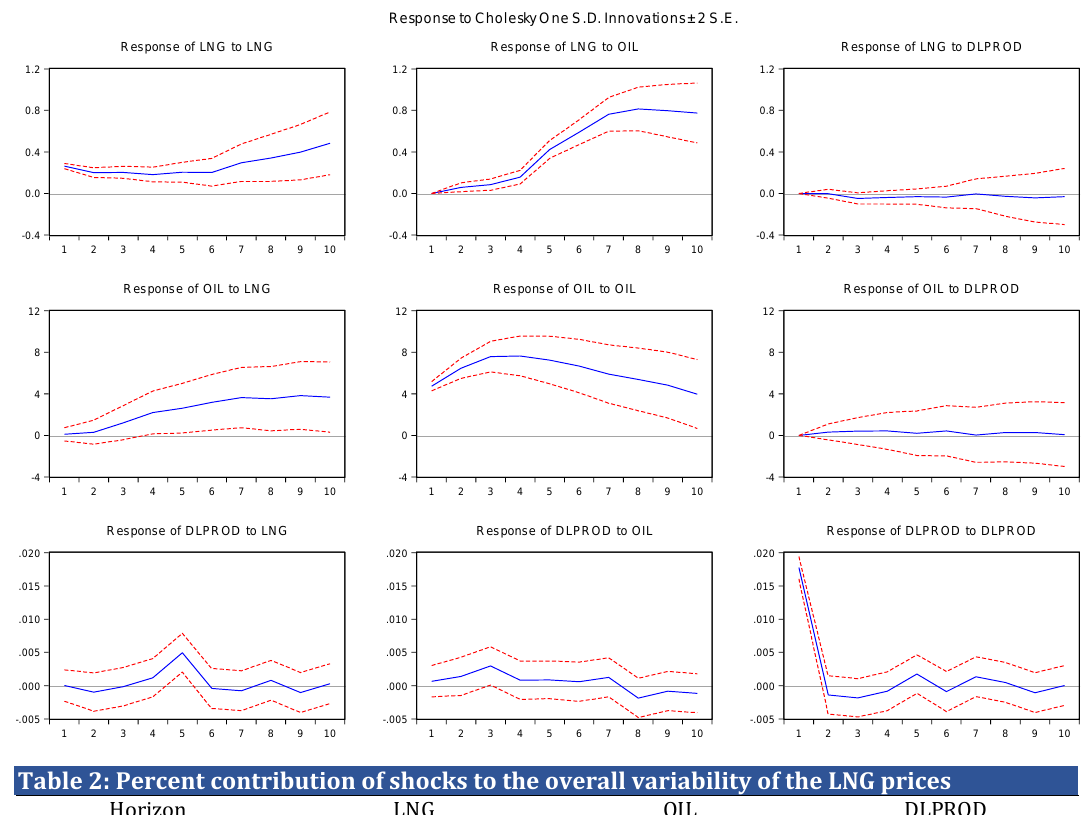
Figure 1: Impulse responses of structural shocks to LNG prices/ 1997-2017